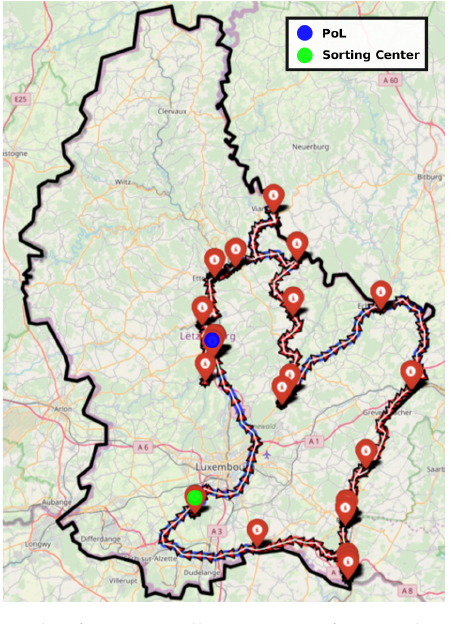
Figure 18. Example of a waste collection tour of a complete working day.